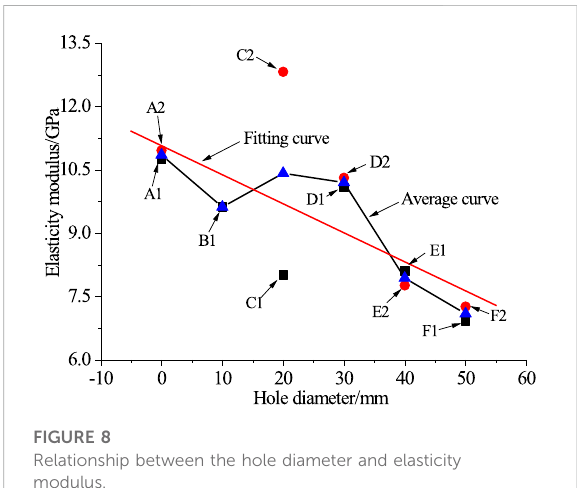
FIGURE 8 Relationship between the hole diameter and elasticity modulus.